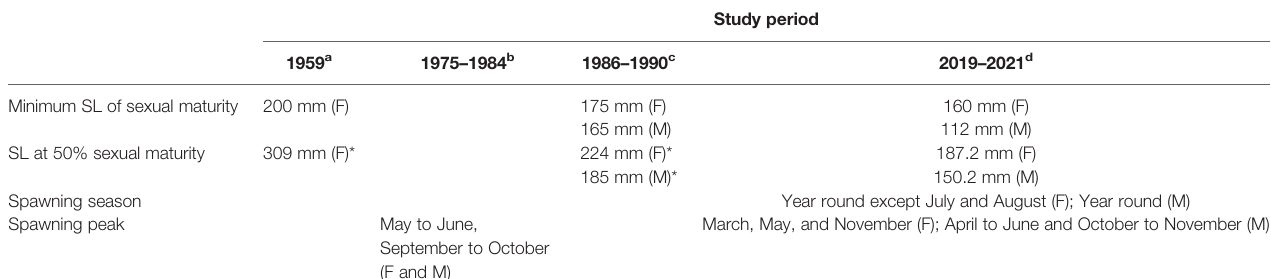
TABLE 3 | Comparison of size at sexual maturity, and spawning season and peak of Larimichthys crocea over years in Guanjingyang spawning